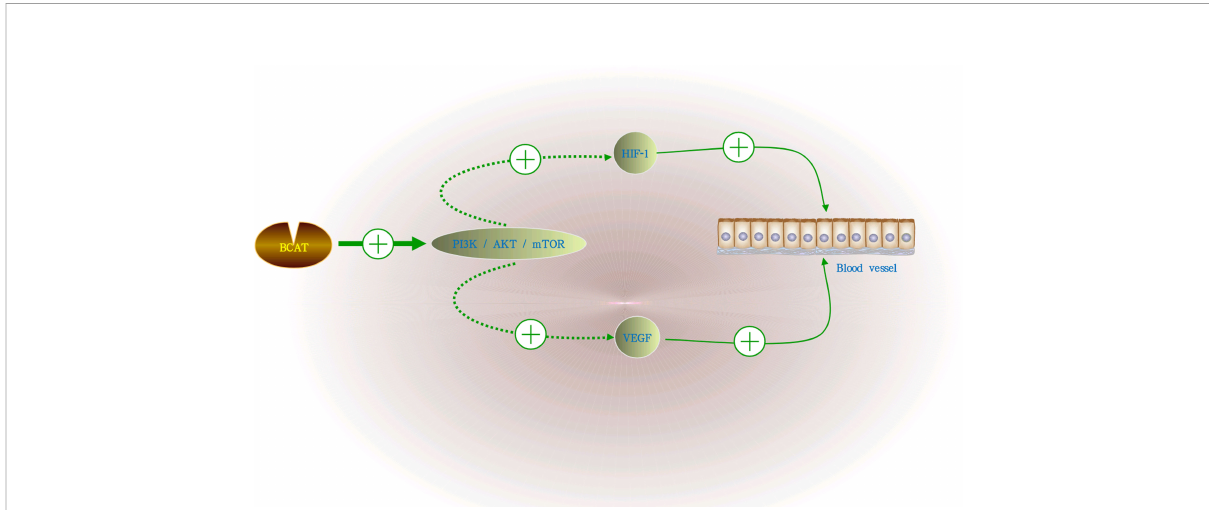
FIGURE 3 The role of BCAT in GC angiogenesis. BCAT1 activates the PI3K/AKT/mTOR signaling pathway during the growth of GC, and the activation of this pathway can induce the secretion of VEGF, HIF-1 and increase the levels of other angiogenic factors, thereby regulating angiogenesis. “ + ” means promotion, “ - ” means